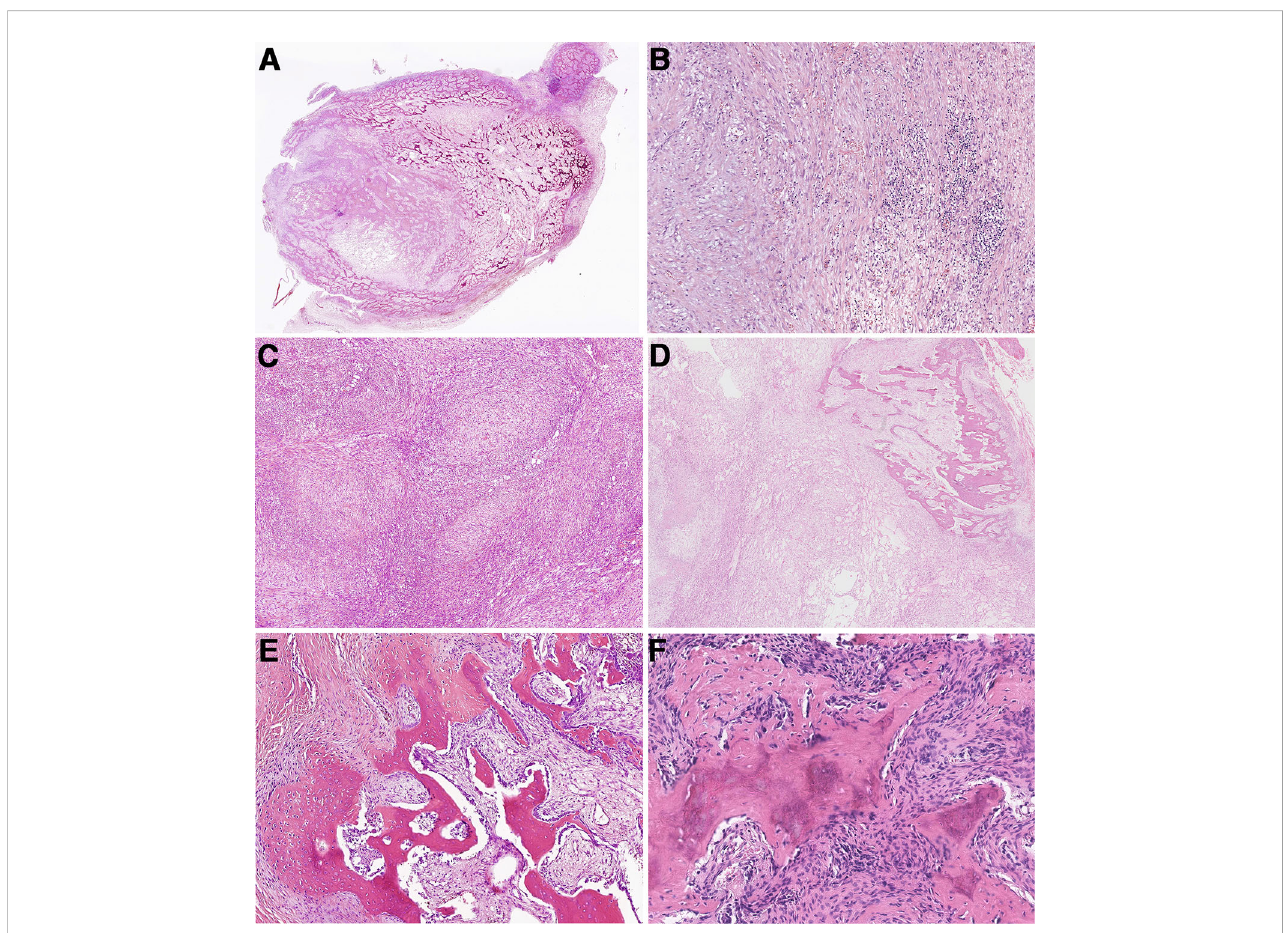
FIGURE 2 Histopathologic characteristics of myositis ossi fi cans and fi bro-osseous pseudotumors of digits. (A) Most myositis ossi fi cans cases were well circumscribed with a typical zonation pattern (Case 33). (B) Myo fi broblasts/ fi broblasts were arranged in bundles in the myxoid stroma, accompanied by extravasated red blood cells and chronic in fl ammatory cells, showing NF-like morphology (Case 33). (C) Extensive NF-like morphology was observed in one myositis ossi fi cans case (Case 42). (D) The tumor formed obvious zonal distribution focally (Case 42). (E) Osteoid components were mature and disorderly in fi bro-osseous pseudotumors of digits (Case 46). (F) Immature osteoid components were observed scattered among the proliferative myo fi broblast/ fi broblast (Case